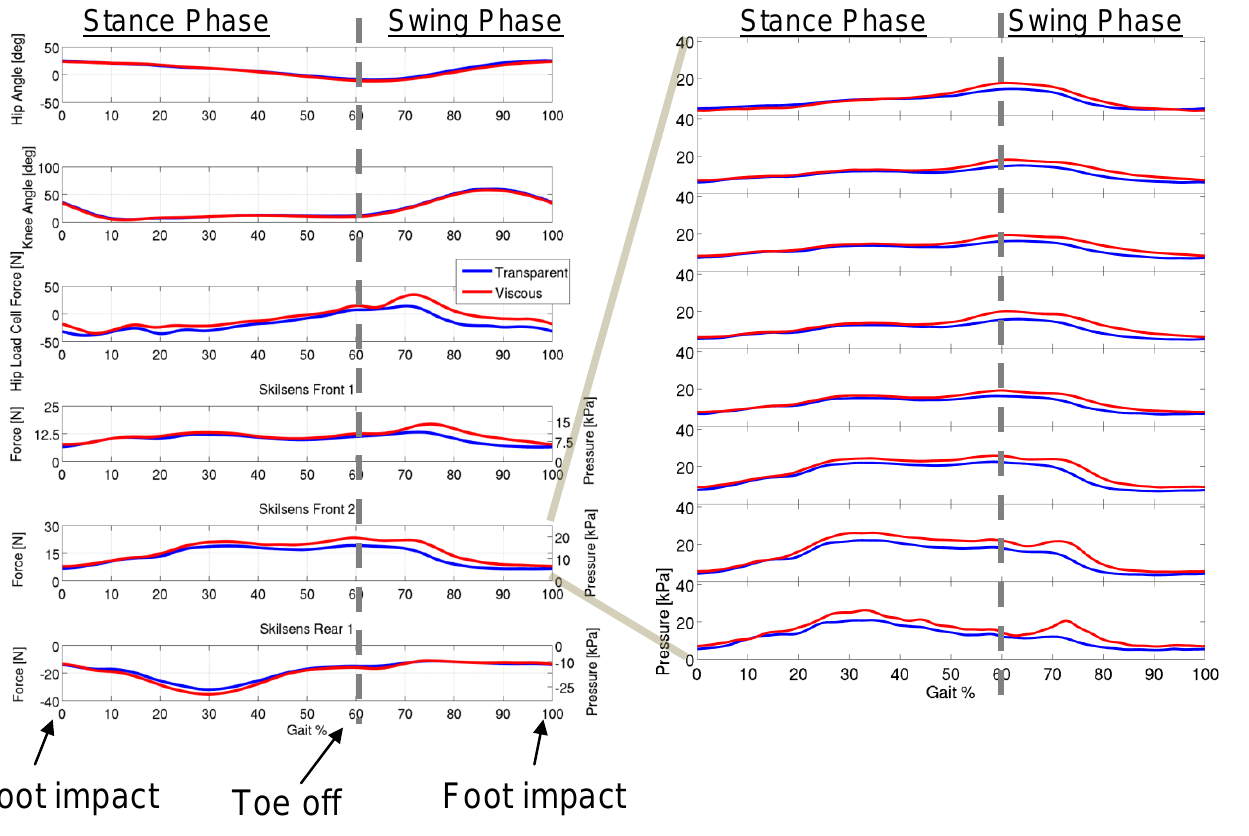
Figure 1. (a) Force on the three pads compared with the measurement of the load cell, during a walking task. (b) Pressure distribution on one of the frontal pads.